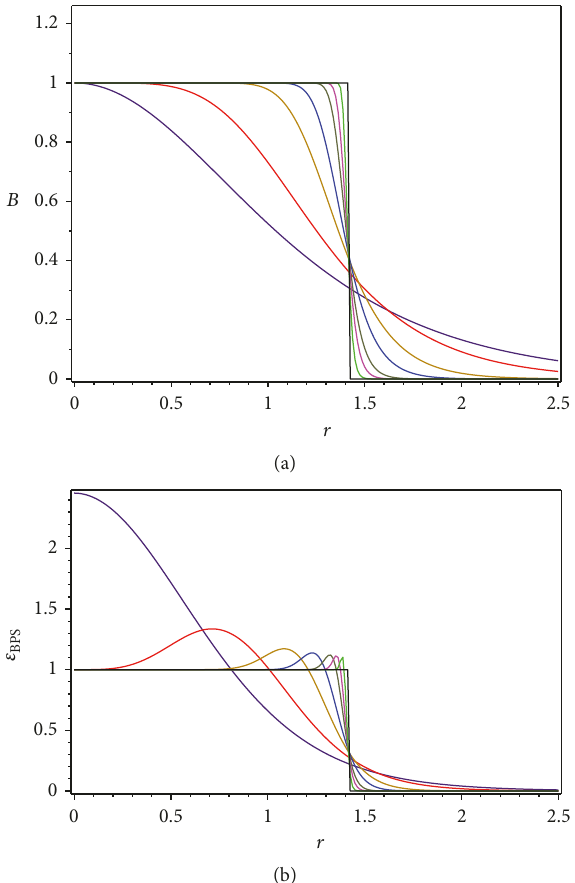
Figure 2: The magnetic field 𝐵(𝑟) (a) and the BPS energy density 𝜀 BPS (𝑟) (b) come from generalized Maxwell-Higgs model (1) with 𝐺(𝑔) = 1 and 𝜔(𝑔) = 𝜆𝑔 2𝜆−2 . Observe that 𝜆 = 1 (indigo lines) represents the usual MH model and the true compacton solution is given by 𝜆 = ∞ (black lines). The convention for the color of the lines is the same given in Figure